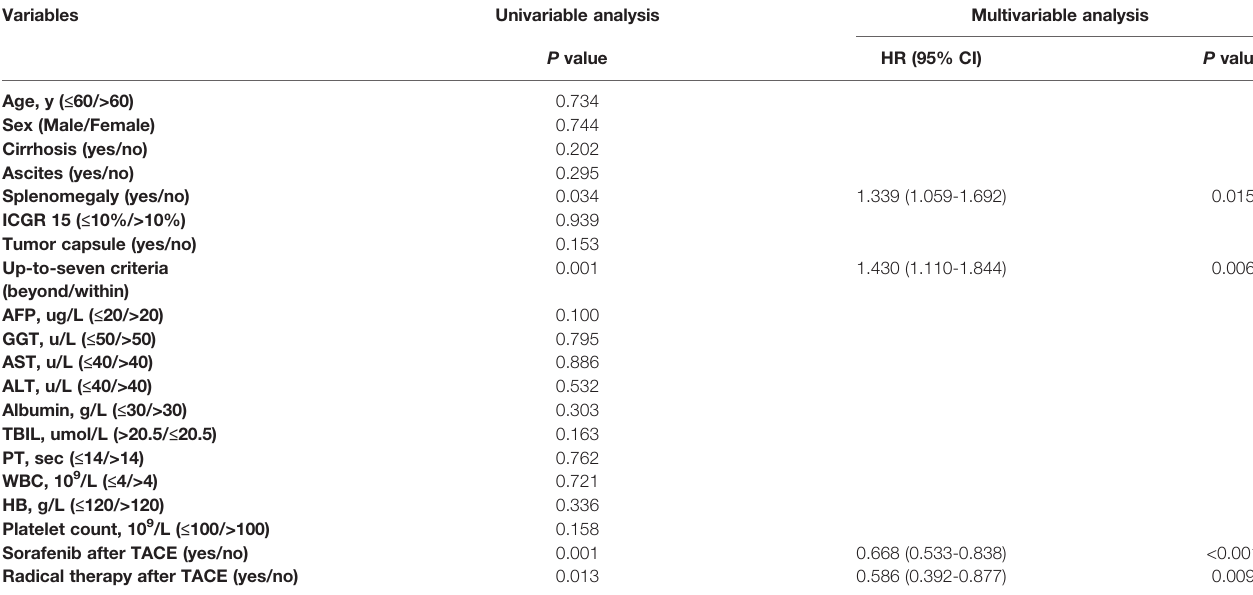
TABLE 4 | Univariable and multivariable analysis of OS in the MVR group.